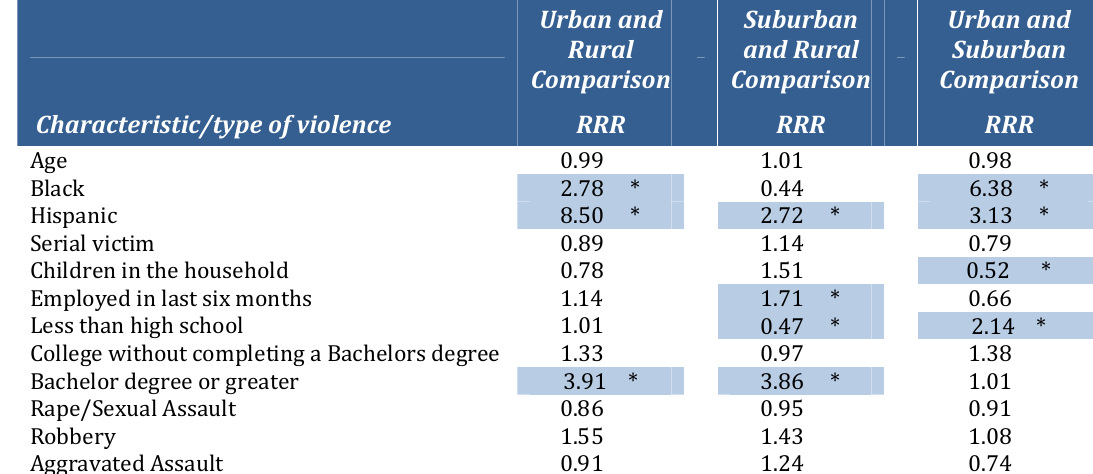
Urban and Suburban Rural and Rural Comparison Comparison